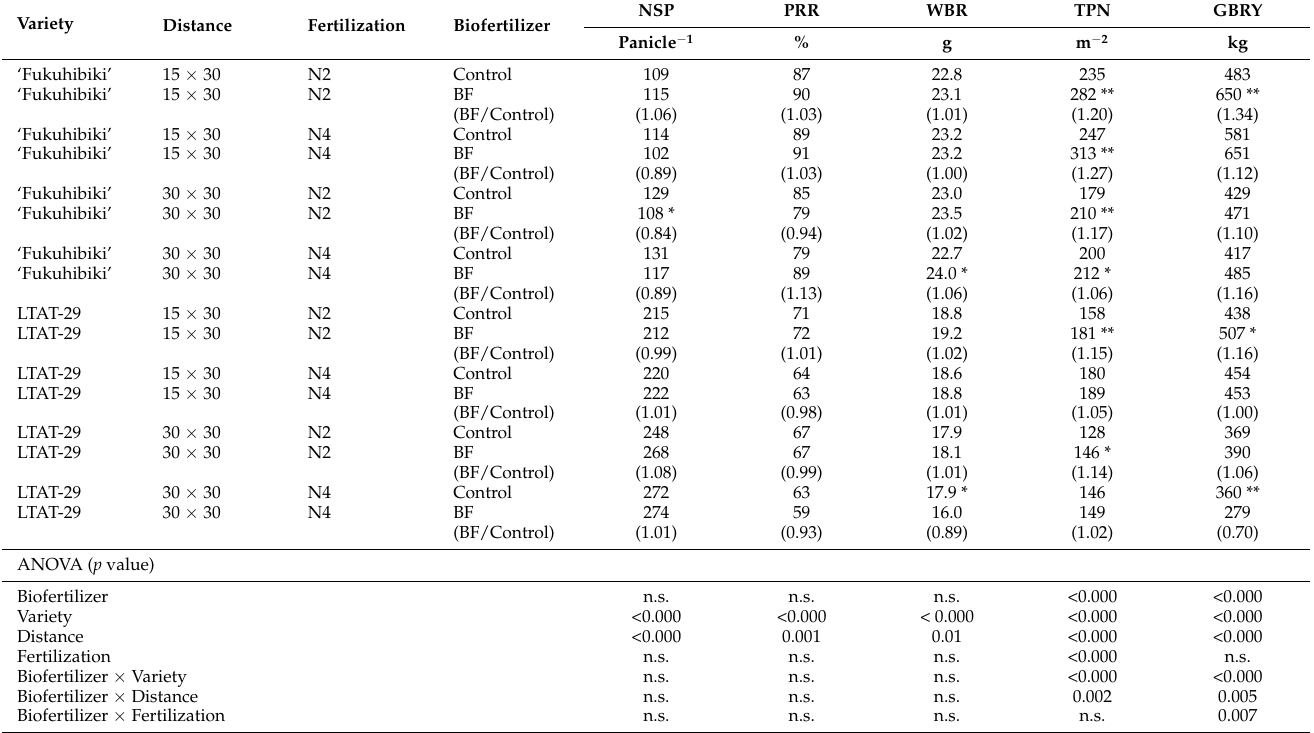
Table 3. Yield components for feed rice ( Oryza sativa L. cv. ‘Fukuhibiki’ and line